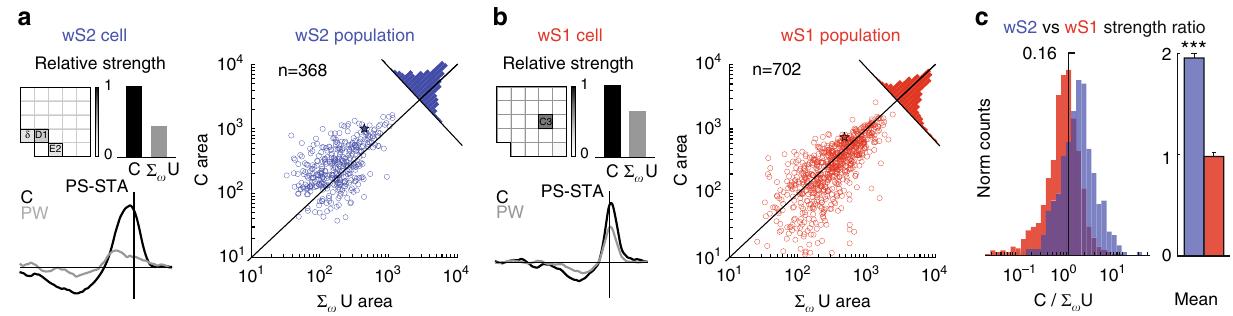
Fig. 6 Supra-linear multi-whisker integration in wS2. a Left: an example wS2 neuron (the same cell from Figs. 3 – 5), Left Top: whisker pad heatmap (same arrangement as in Fig. 4a) and bar plot showing the relative response strength (integral of PS-STA) of the neuron to individual whiskers during uncorrelated stimulation compared to the response strength to correlated stimulation, Bottom: The PS-STA for the principal whisker (light gray curve) during uncorrelated stimulation and the correlated stimulation (black curve). Right: the population distribution of neurons in wS2 with the sum of the individual whisker strengths from the uncorrelated stimulation (log scale) on the x -axis and the strength of the correlated response (log scale) on the y - axis. The star on the plot corresponds to the example cell and the histogram on the top right illustrates the distribution of the ratios. b Same as a but for a wS1 example neuron (same neuron as shown in Figs. 3 – 5) and the wS1 population. c Left: The two histograms from parts a and b overlaid. Right: A bar plot comparing the mean strength ratios between the correlated stimulation and the sum of individual whiskers in the uncorrelated stimulation. Signi fi cance ( p < 0.001) assessed by shuf fl ing cell/region mappings and computing difference in means. Bar plot whiskers are standard